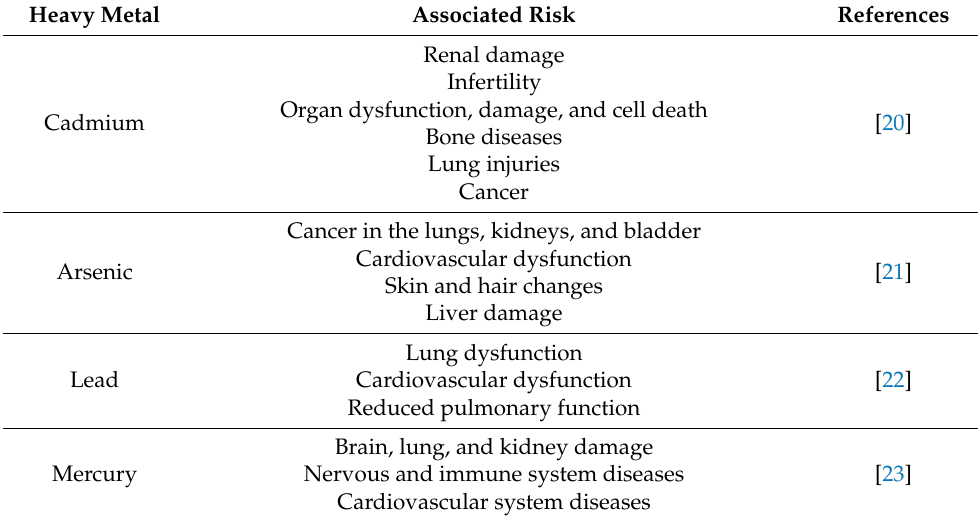
Table 1. Heavy metal risks for human